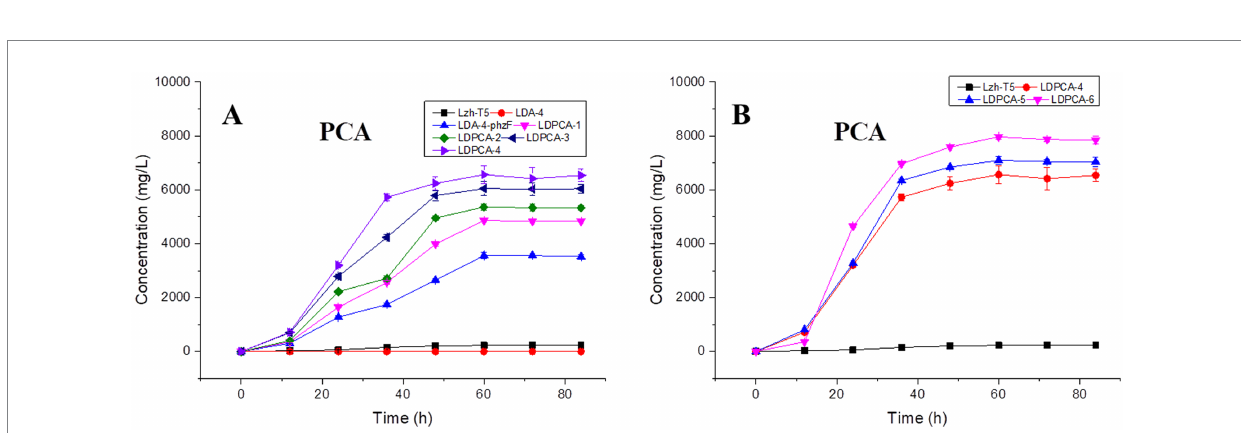
FIGURE 5 Effects of genetic modifications on PCA production. (A) PCA production of non-scar deletion strains. (B) PCA production of gene over-expression strains. The data represent the means ± SD for three independent